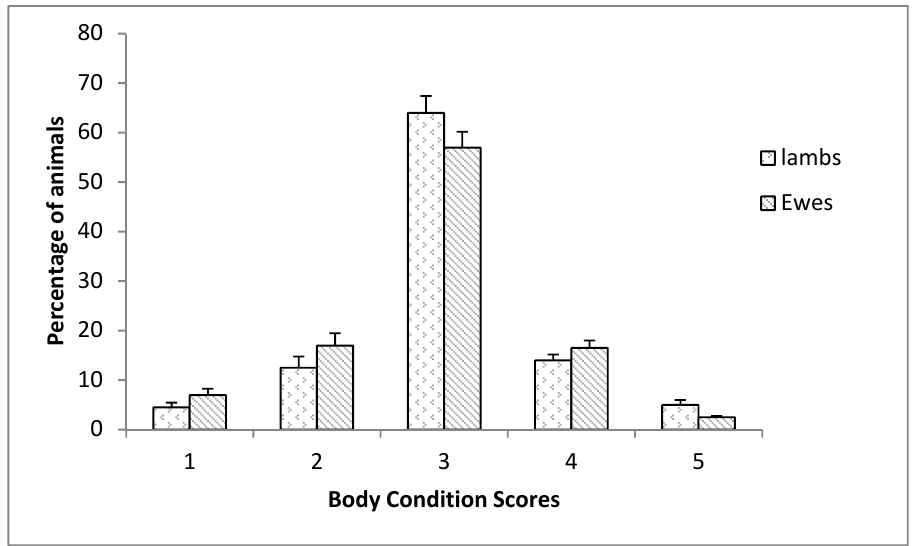
Figure 1. Distribution of the average scores of body condition for the studied sheeps at lambing, mid-lactation, and weaning.